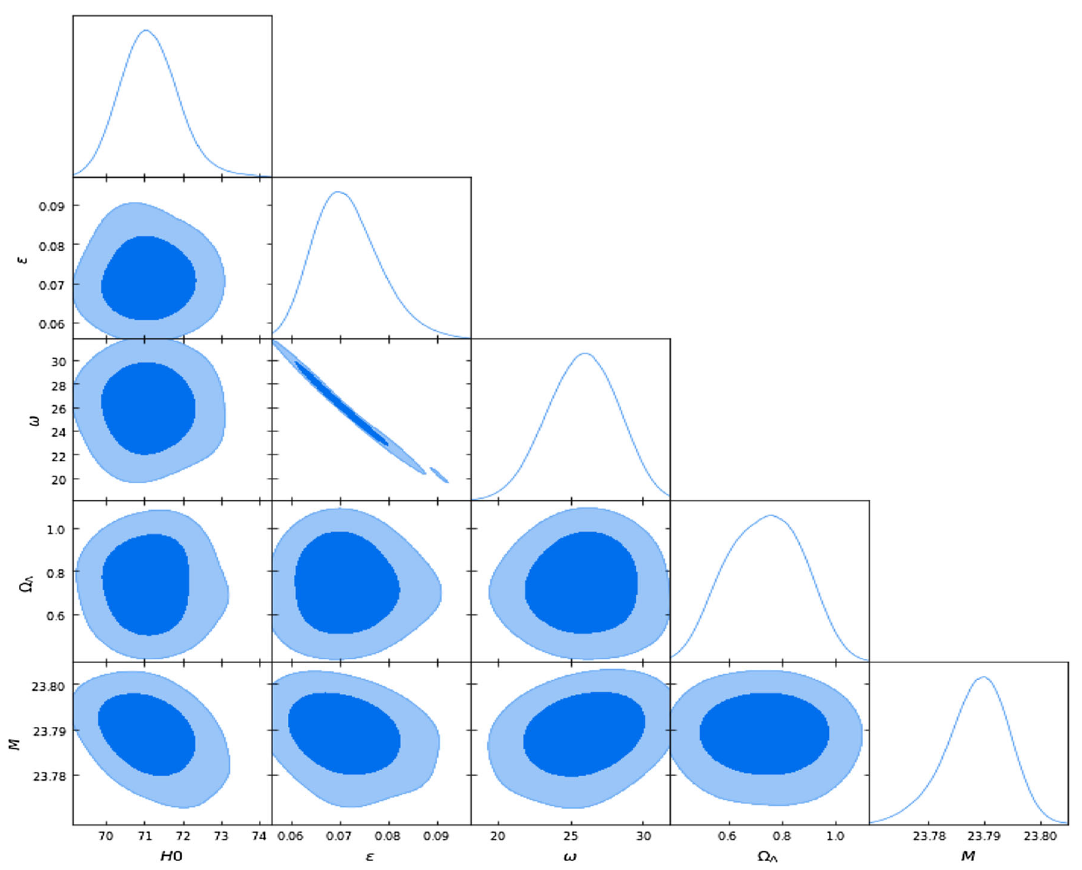
Fig. 1 One dimensional and two-dimensional marginalized confidence regions for the model parameters of Λ H 1 from DS1 data set